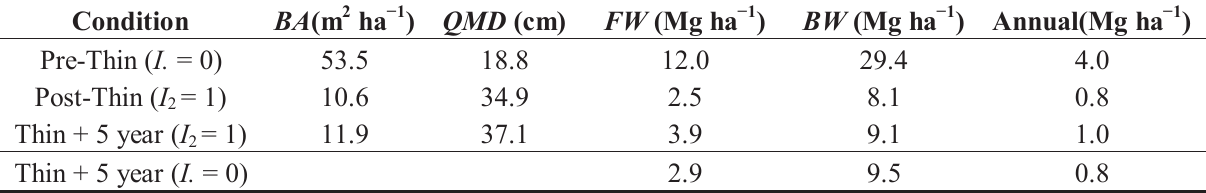
Table 5. Estimates of foliage weight ( FW ), branch weight ( BW ) and annual litter fall estimate (Annual) using I = 1 in model 6 for post-thin estimates, including error from 2 application of unthinned model ( I . = 0) five years post